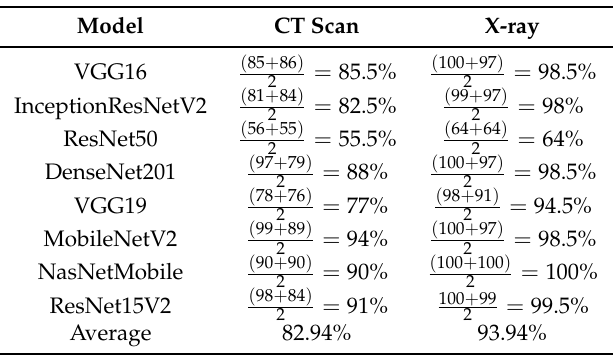
Table 10. Models average accuracy on both datasets.